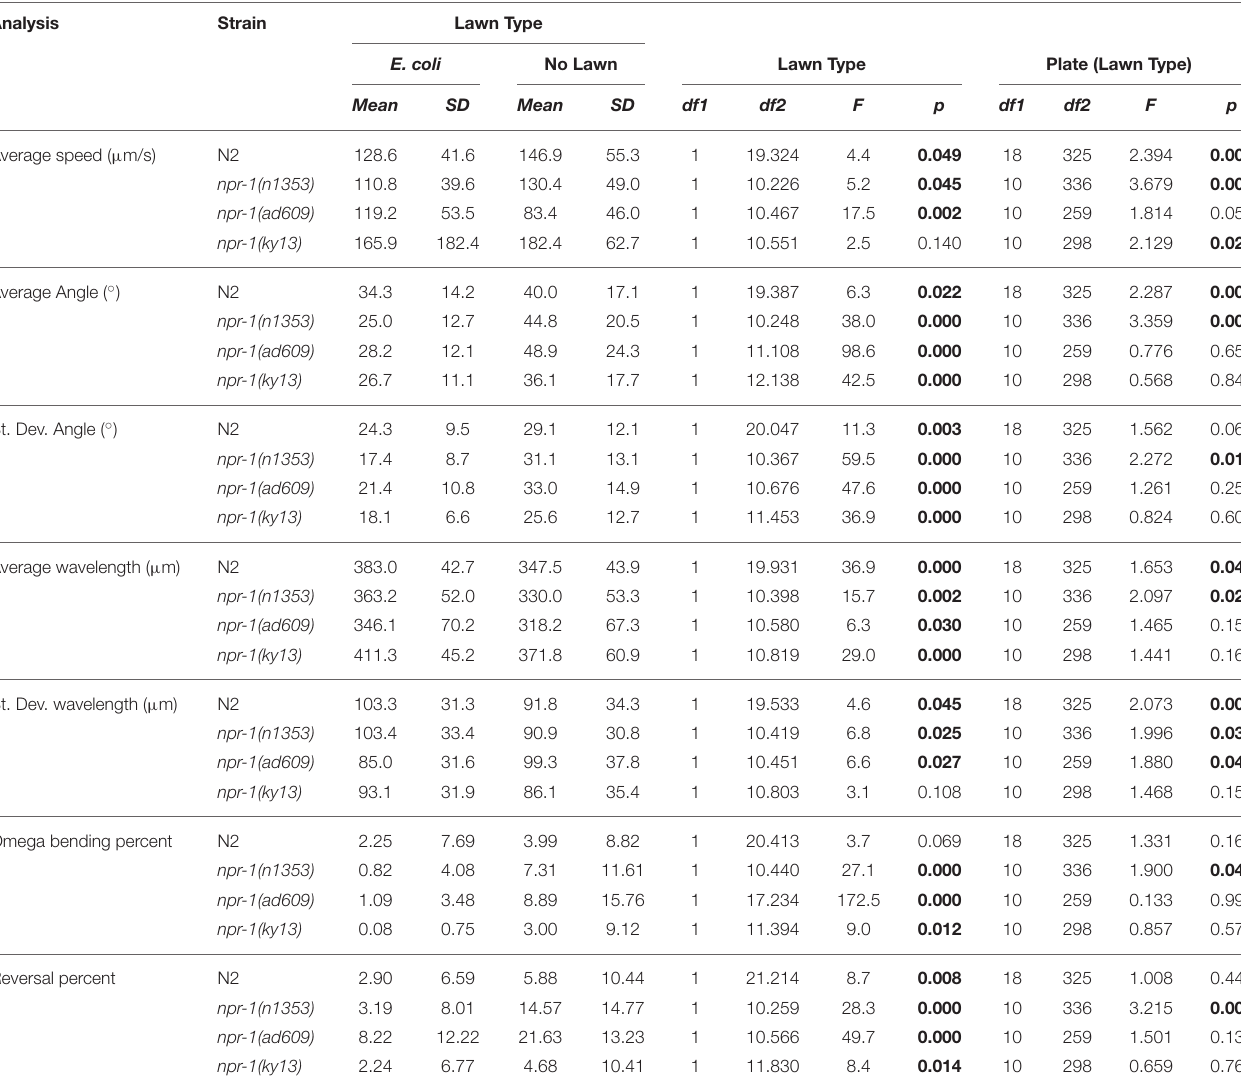
TABLE 2 | Summary of analyses and comparison between C. elegans on plates with E. coli and no lawn.